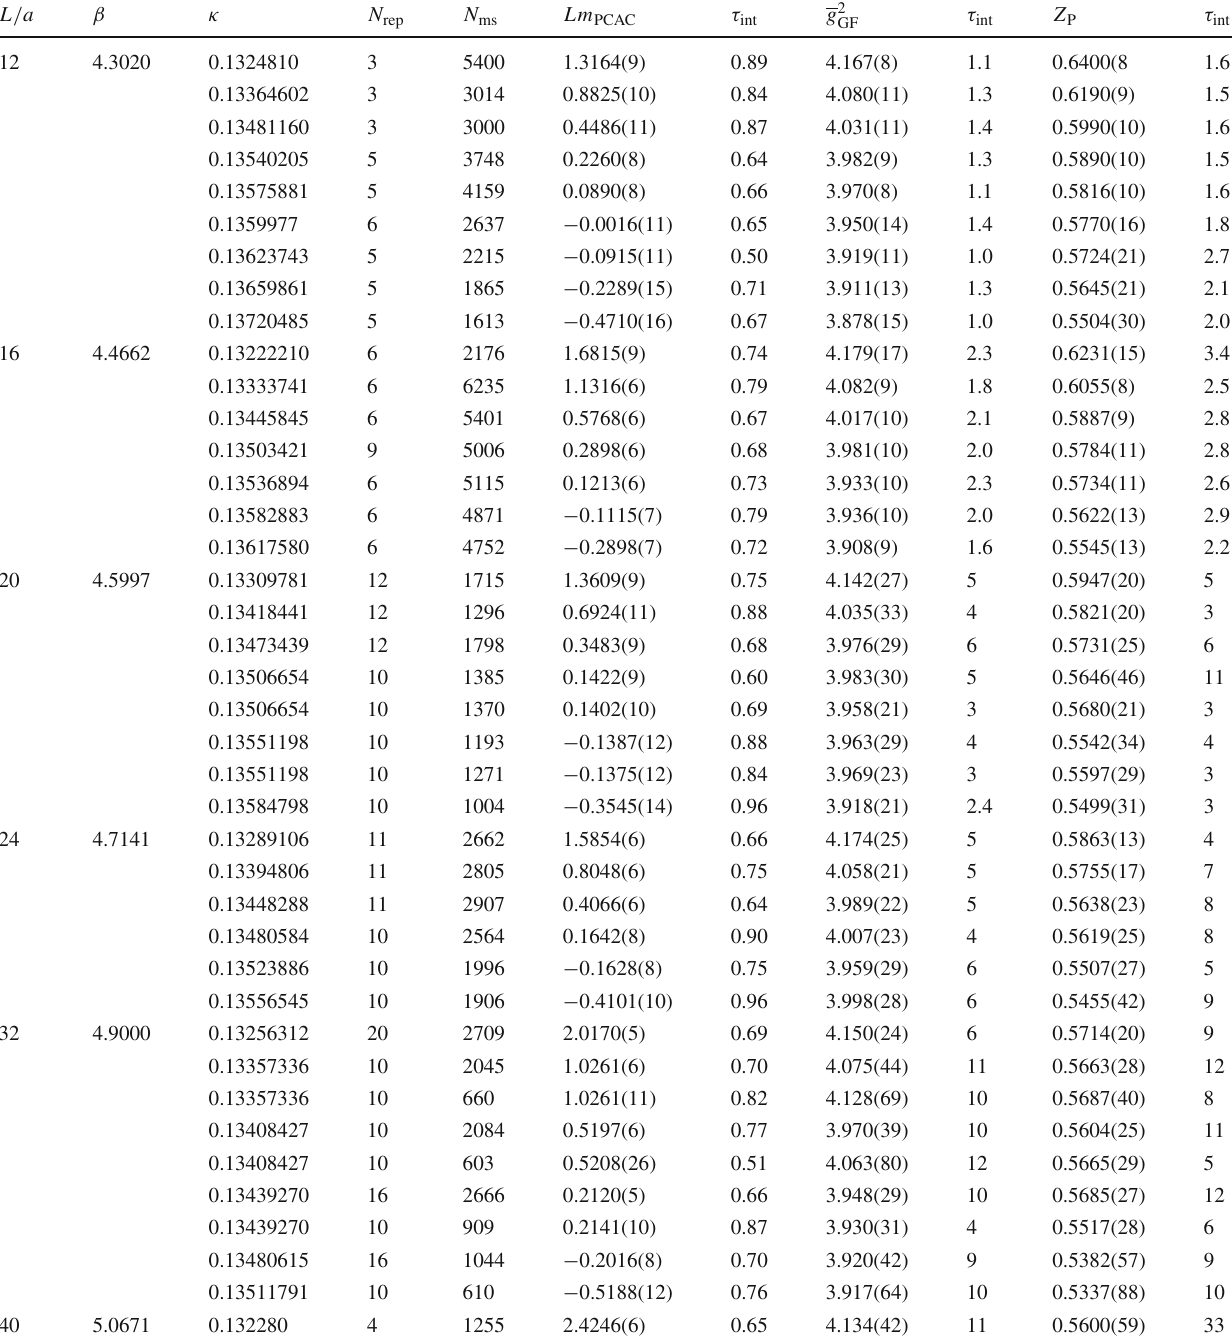
Table 12 Results for Lm PCAC , g 2 and Z P from massless renormalization runs and their integrated autocorrelation times τ int in units of measure- GF ments (every five trajectories, i.e., 10